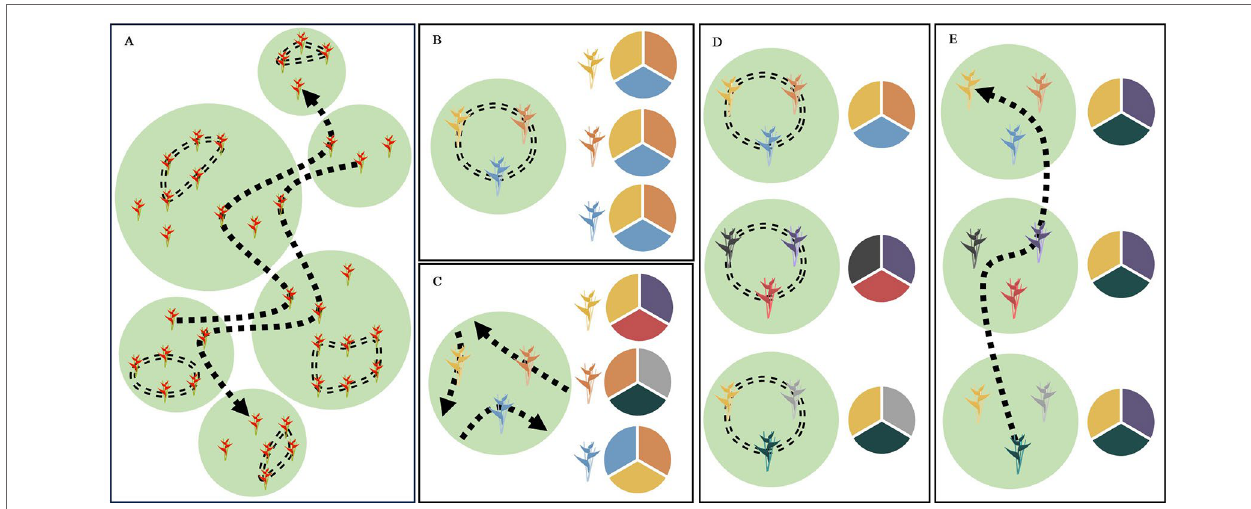
FiGUrE 2 | Schematic diagrams of the foraging strategies of territorial and traplining hummingbirds and their expected effect on the differentiation of pollen pools sampled among forest fragments and among neighboring plants within forest fragments. Suitable habitat for both H. tortuosa and its pollinators is represented in green with the matrix shown in white. (a) The foraging strategy of territorial hummingbirds is shown by a double-dashed line. These pollinators enhance pollen transfer among neighboring plants and reduce pollen flow among forest fragments. The foraging strategy of traplining hummingbirds is shown by a single-dashed line. These pollinators reduce pollen flow among neighboring plants and enhance pollen transfer among forest fragments. (B) Pollination by territorial hummingbirds leads to neighboring plants sampling the same local pollen pool, as these pollinators transfer pollen among plants within their territory and often visit multiple flowers within a clump of inflorescences. This leads to non-significant differentiation of pollen pools sampled by neighboring plants. (c) Pollination by traplining hummingbirds leads to neighboring plants sampling distinct pollen pools, as these pollinators will visit particular plants along different high-fidelity routes. This leads to significant differentiation of pollen pools sampled by neighboring plants. (D) Pollination by territorial hummingbirds reduces pollen flow among forest fragments, increasing pollen pool differentiation among sites. (E) Long-distance pollen transfer by traplining hummingbirds enhances pollen flow among forest fragments, reducing pollen pool differentiation among sites. Allele frequencies in pollen pools are represented by pie charts, where each color indicates a different allele.